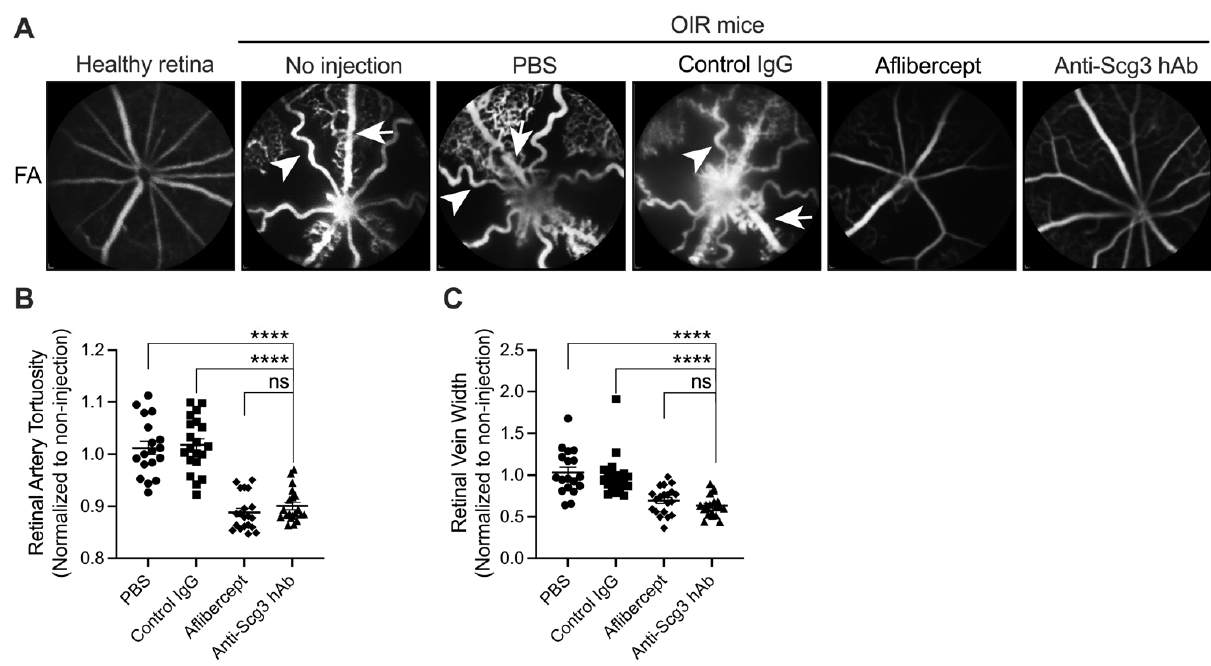
Figure 2. Intravitreal anti-Scg3 hAb ameliorates aberrant retinal artery tortuosity and decreases vein width in OIR mice. ( A ) Representative FA images of OIR mice treated with the indicated agents (2 µg/0.5 µL/eye). Arrowheads indicate tortuous arteries; arrows show dilated veins. ( B ) Quantification of retinal arterial tortuosity in ( A ). Tortuosity index = actual vessel length/linear length. ( C ) Quantification of vein width in ( A ). Mean ± SEM; n = 10 eyes (non-injection), 18 (PBS), 20 (control hIgG), 20 (aflibercept), and 23 (anti-Scg3 hAb). **** p < 0.0001; ns, not significant; one-way ANOVA test.